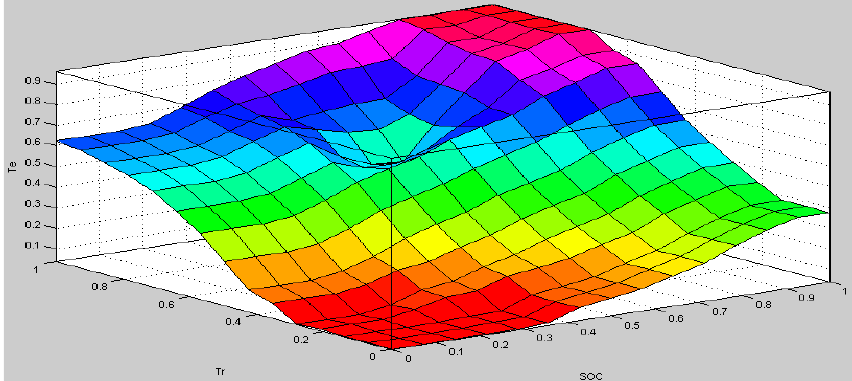
Figure 4. Engine output torque membership function.